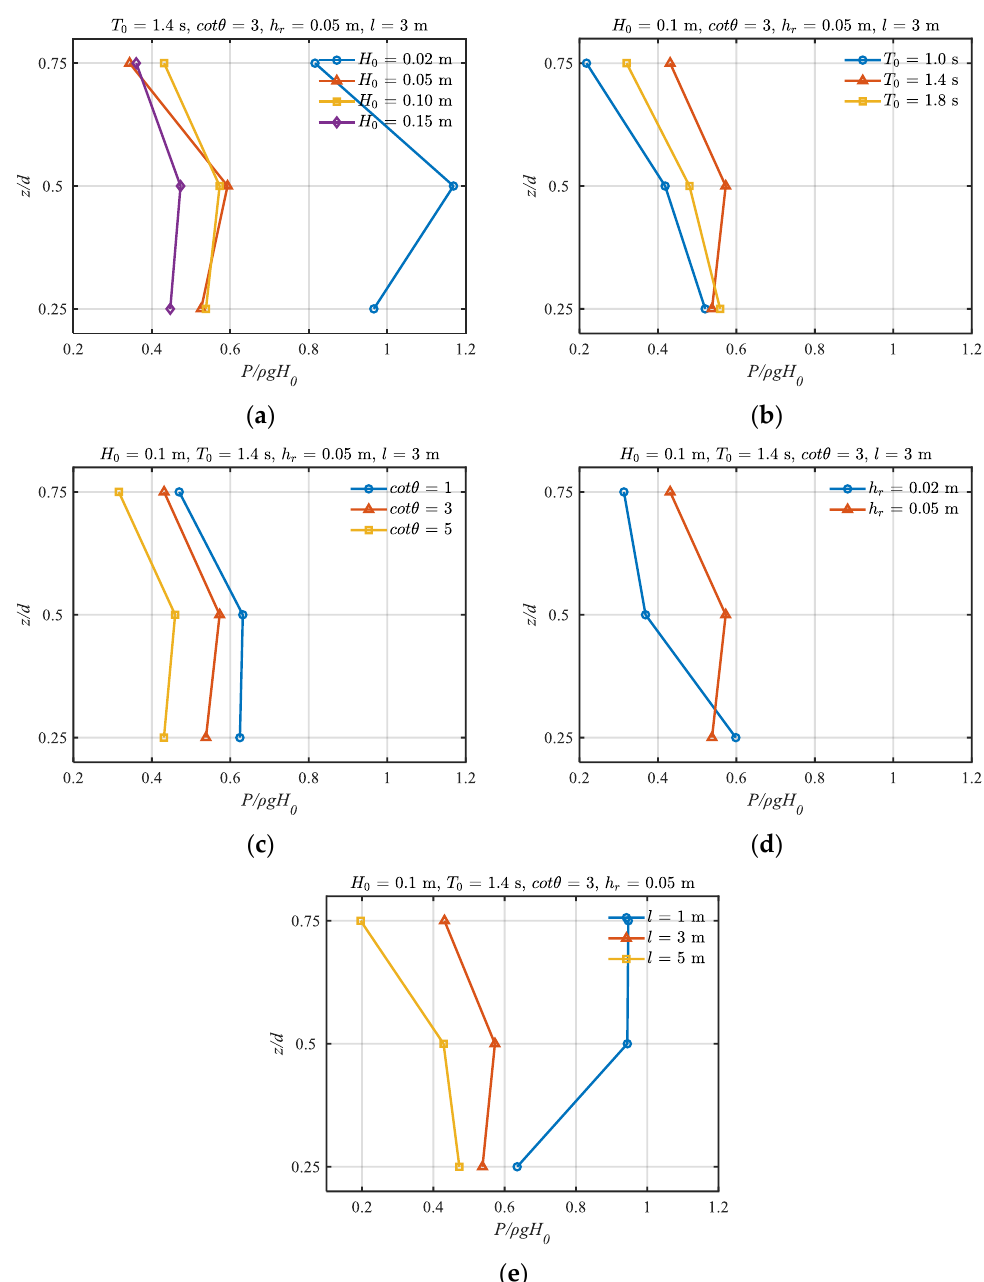
Figure 16. Regular wave peak pressure distribution along the front surface of the vertical seawall for different cases: ( a ) H 0 ; ( b ) T 0 ; ( c ) cot θ ; ( d ) h r ; ( e ) l .